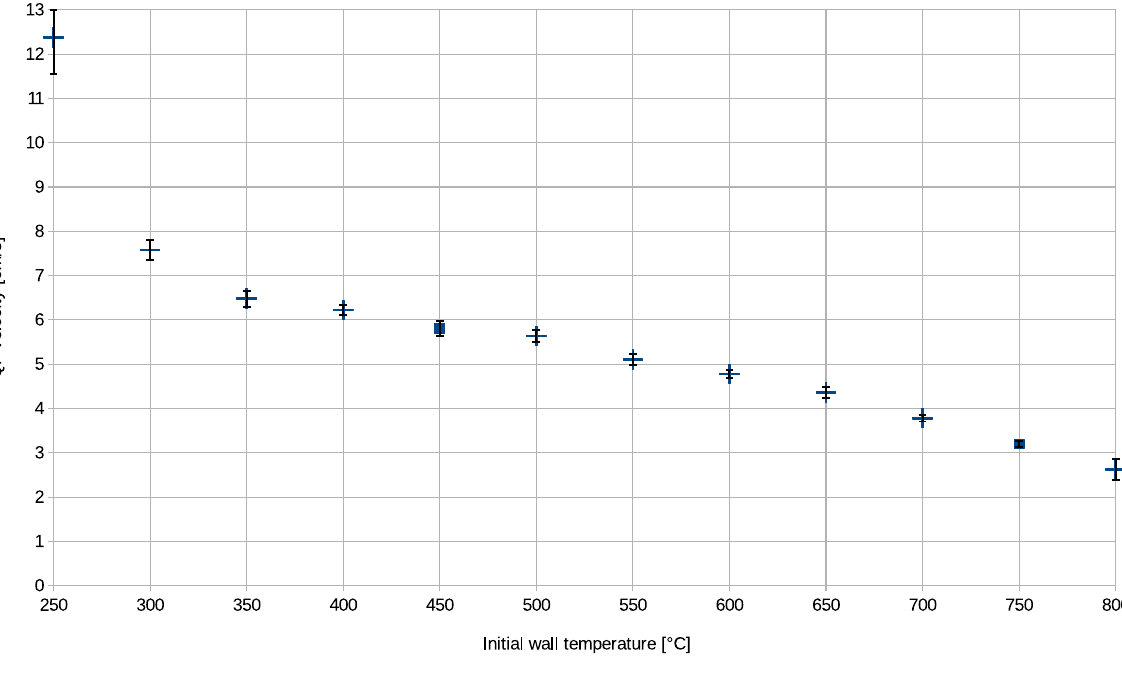
Figure 3. Quench front velocity on initial wall